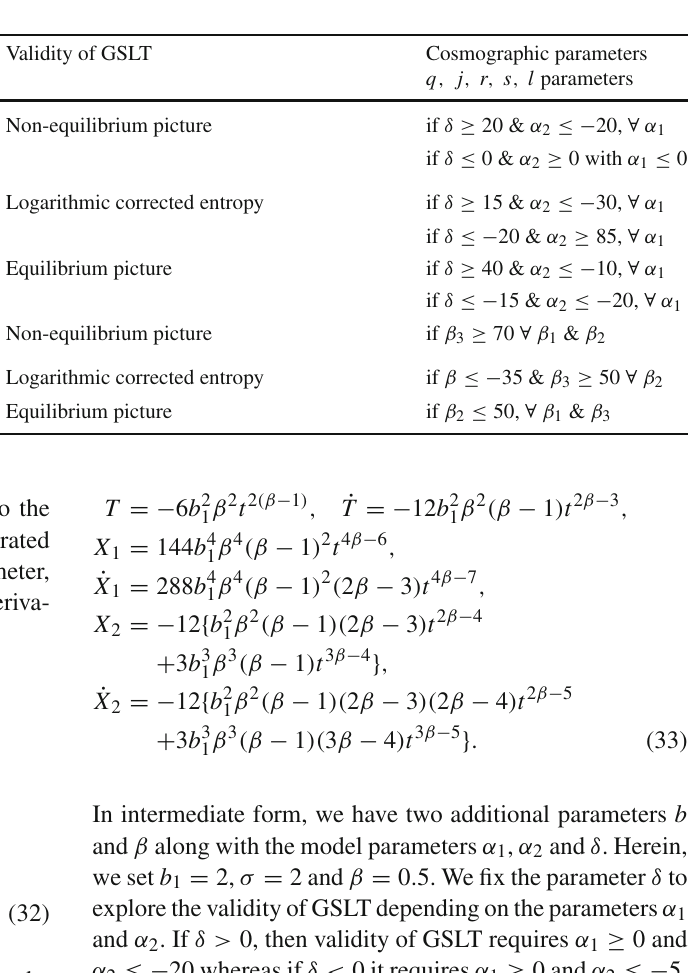
˙˜ S tot ≥ 0 for different models